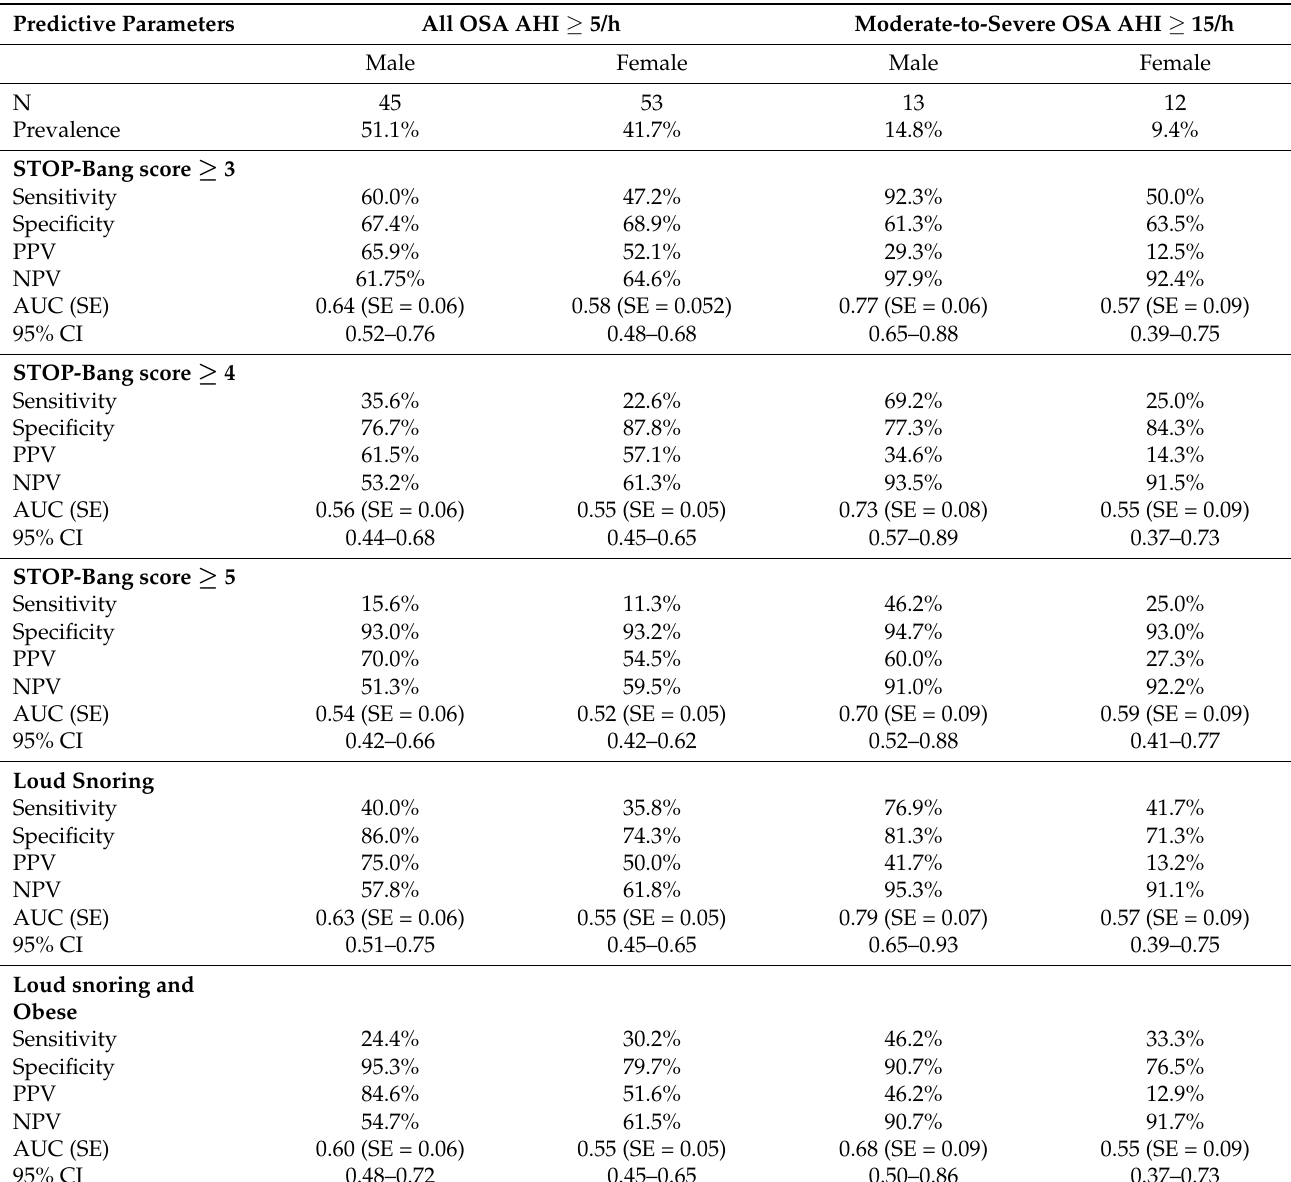
Table 4. Predictive parameters of STOP-Bang score, loud snoring, loud snoring and obese to screen for OSA in First Nations People by